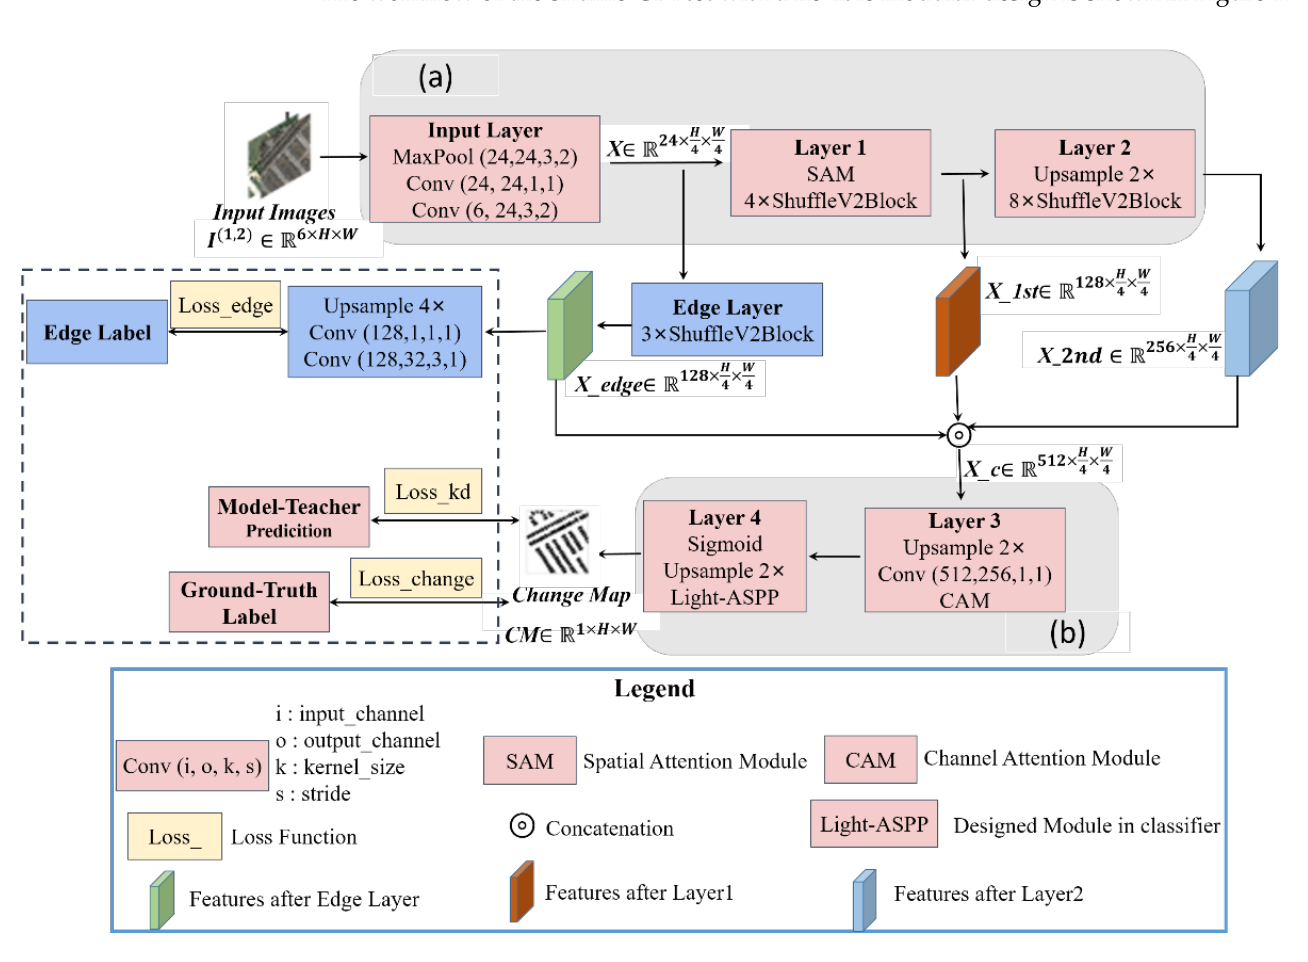
Figure 1. Workflow of the proposed change-detection network. ( a ) Backbone: based on Shuf- fleV2Block, which generates the multilevel features. It accepts the six-channel image that concatenates the bitemporal images by channel. ( b ) Classifier: accepts the fusion features and generates the binary change map.